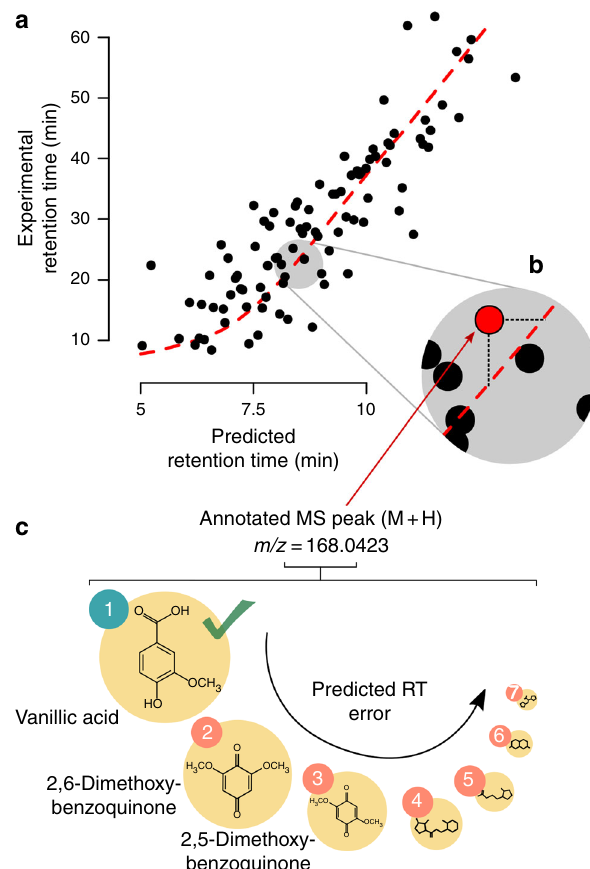
Fig. 4 RT projection scheme. a The RT of identi fi ed compounds eluting in two chromatographic methods (CMs) can be used to build a projection function (red dashed line). We determined this projection function by comparing predicted RT values (in the CM used to acquire the METLIN ’ s SMRT dataset) to experimental RT values in a different CM (predicted – experimental projection). b This function enables projecting all the predicted RTs from their speci fi c CM onto other experimental CMs. c By performing an accurate mass search, we can determine all possible known structures that could be attributed to any annotated protonated (M + H) or deprotonated (M − H) ion m/z . Predicted RT allows ranking this putative candidates by prediction